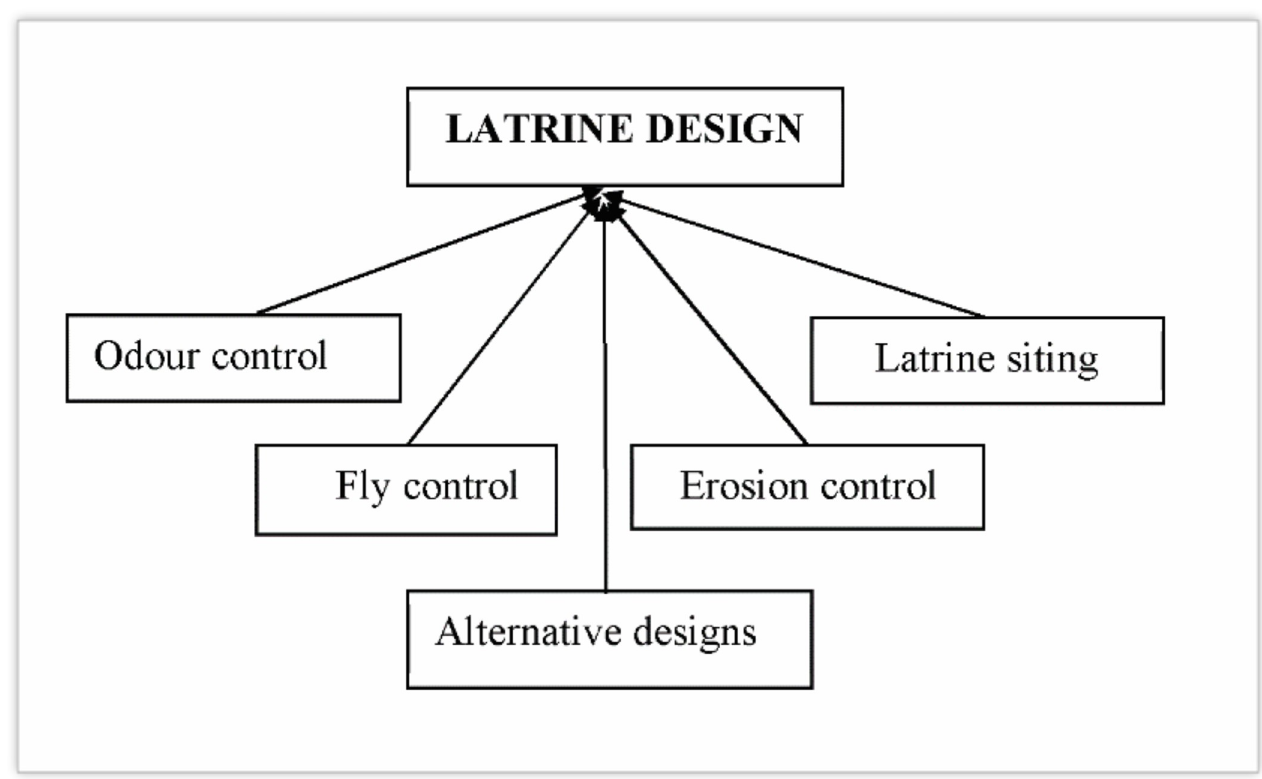
Fig 8. Adaptation strategies of the BVIP latrine to climate change from focus groups, Mbire district, Zimbabwe, 2021.